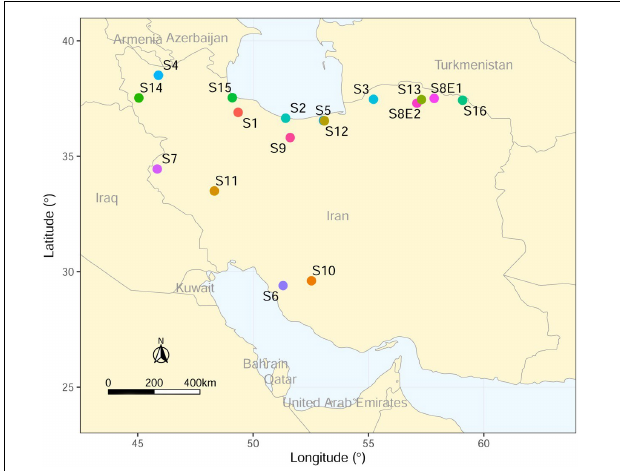
FIGURE 1 | Collection sites of Iranian endemic Pimpinella species on the map of Iran using